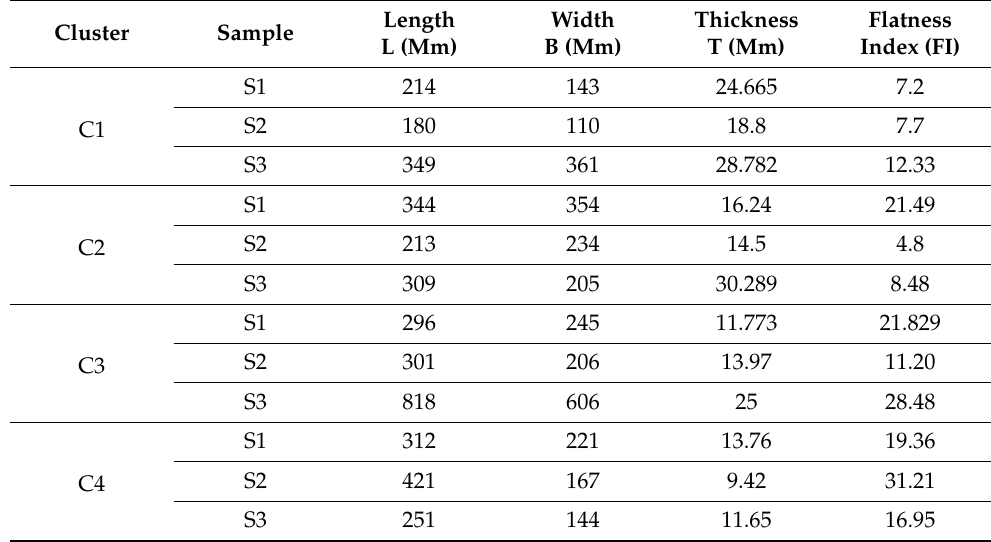
Figure 6. ( a , b ) SEM microphotographs interpreted as rounded gold grains affected during transport in the Indus River, whereas ( c – f ) indicate sub-rounded, smooth, and flattened morphology of gold grains from the study area, where l-l’ (length), and b-b’ (breadth) of the grains. Table 3. Morphological parameters include length, width, thickness, and flatness index of selected gold grains from the study